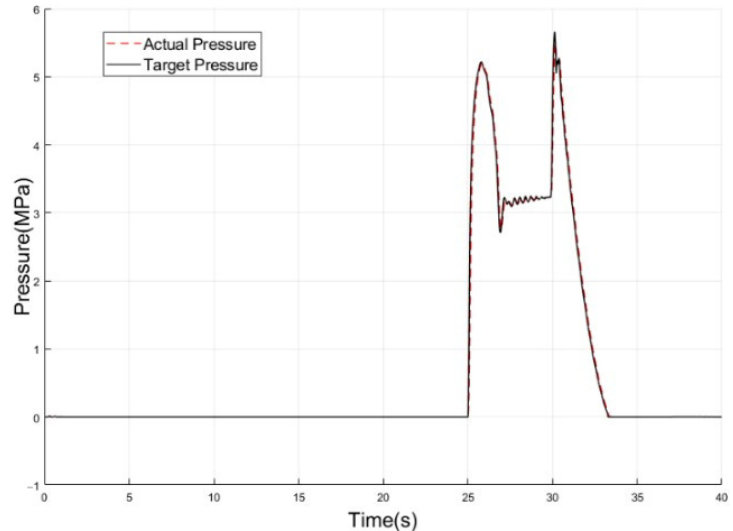
Figure 16. Pressure control effects.